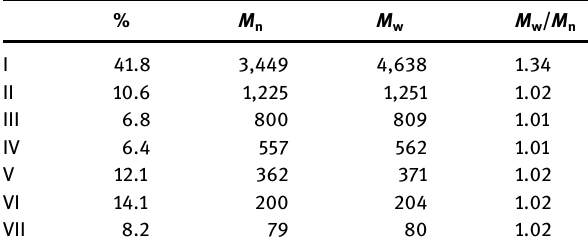
Table 2: GPC parameters of PNR